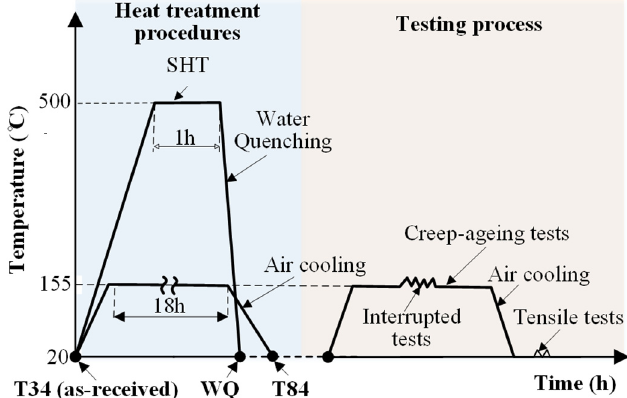
Fig. 1. Schematic of heat treatment procedures and subsequent testing conditions.